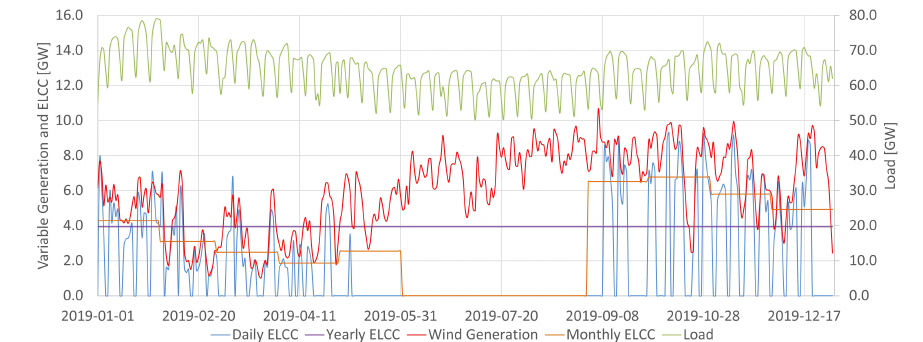
Figure 6. Daily, monthly and yearly ELCC for wind power in 2019 for the SIN.